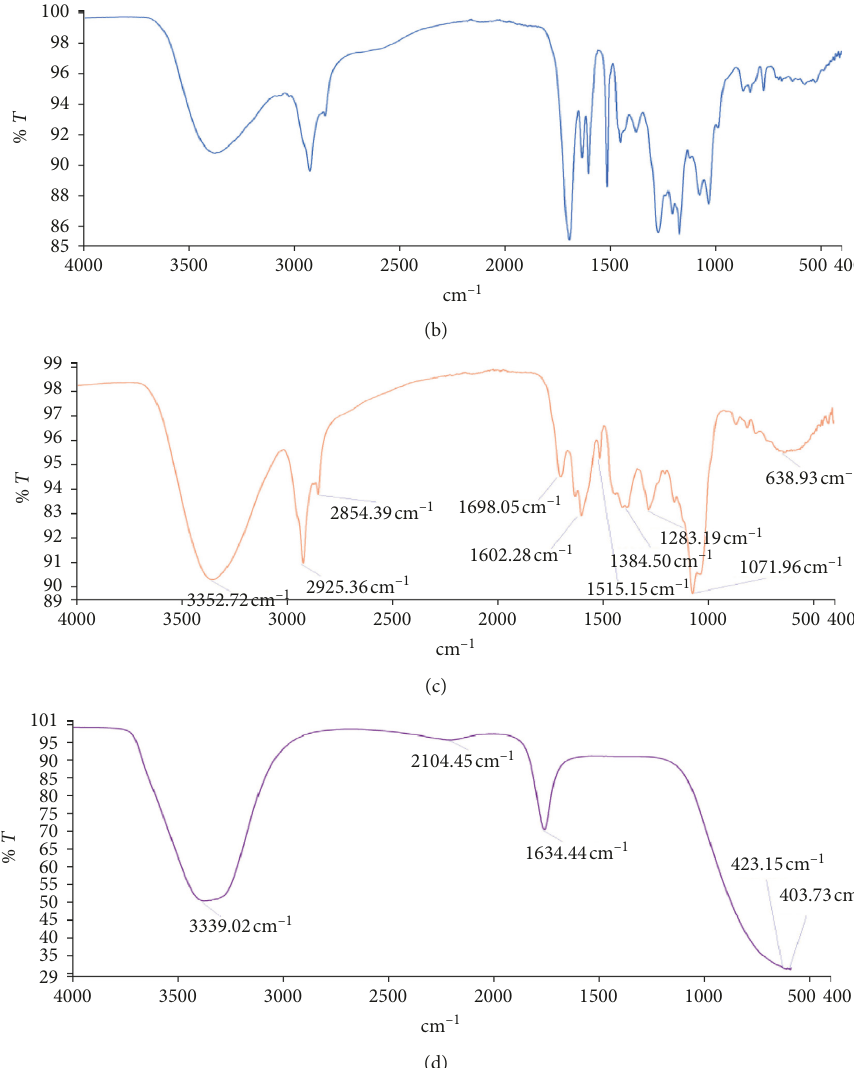
Figure 3: FTIR spectrum of petroleum ether (a), ethyl acetate (b), methanolic (c), and hydro fraction (d) of D. erecta ripe fruit